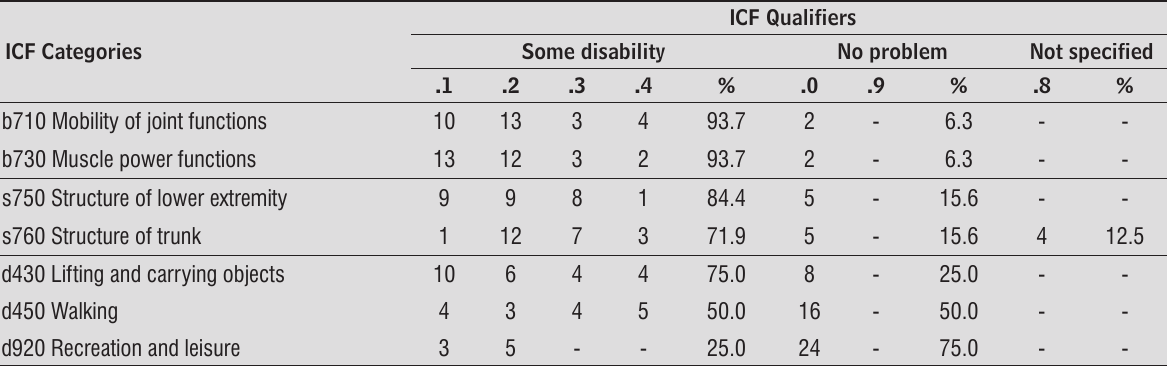
Table 2 - Frequency of older women with body function, body structure and activities and participation disabilities (n = 32) ICF Categories